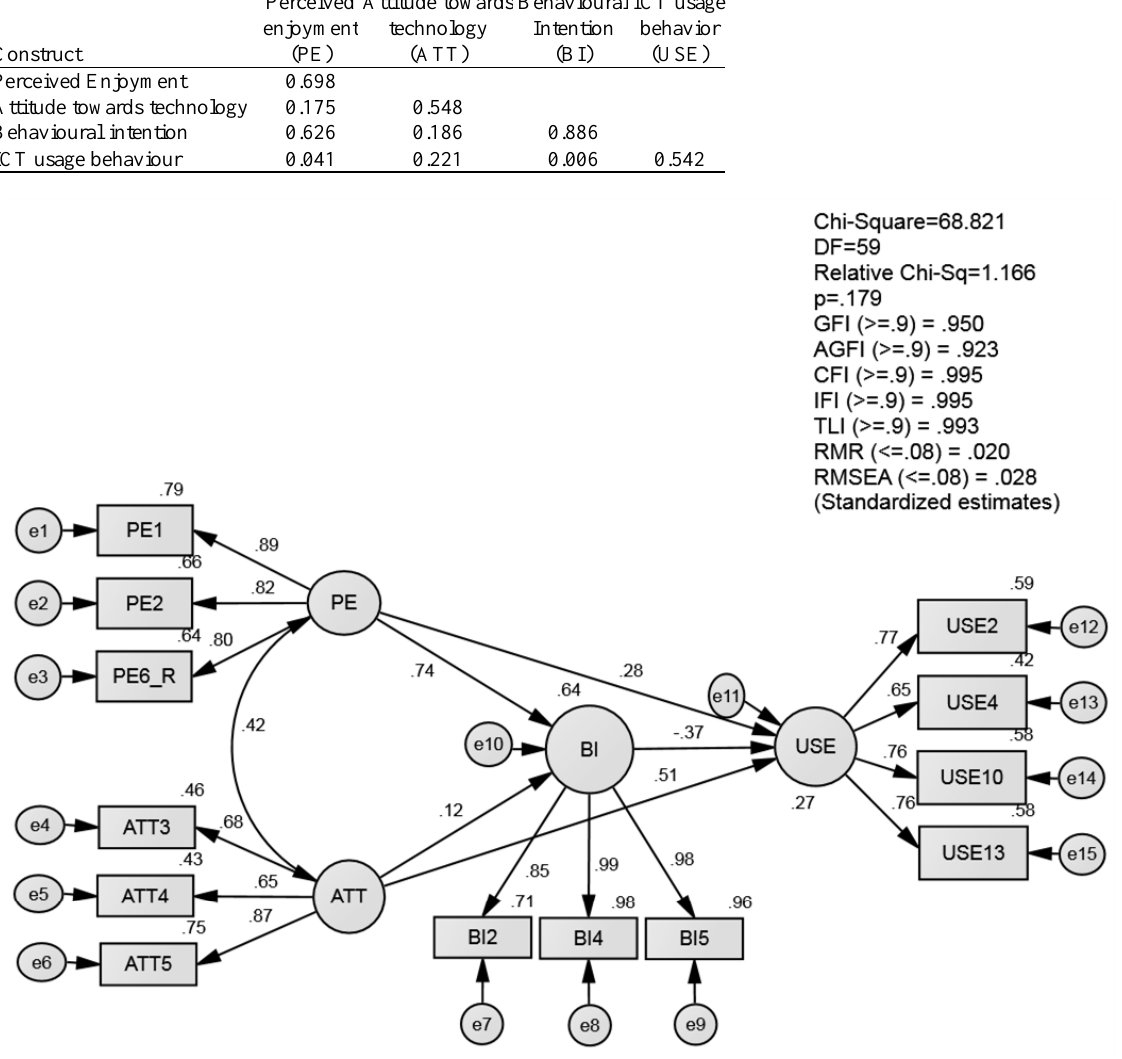
Table 3 Discriminant validity for the measurement model